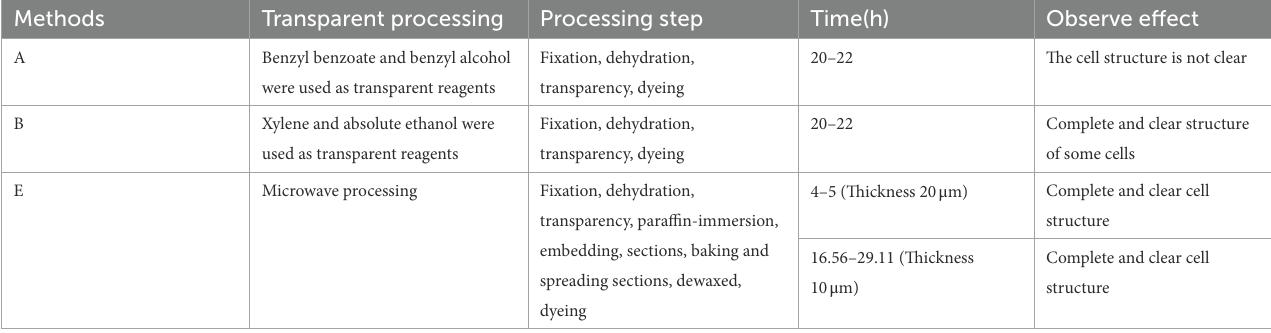
TABLE 4 Comparison of the observation preparation methods and effects of longitudinal section cell morphology of Chinese fir roots.